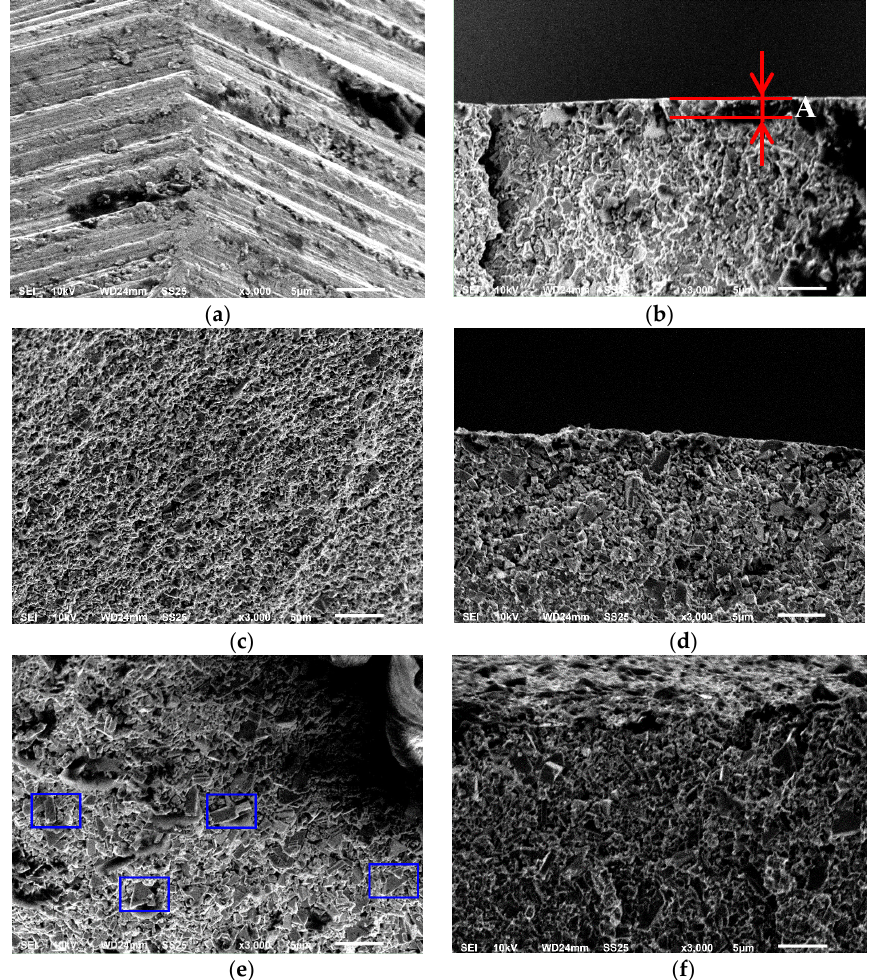
Figure 6. SEM images of the ( a ) surface and ( b ) cross-sectional surface of the original substrate, ( c ) surface and ( d ) cross-sectional surface of the substrate after chemical etching pretreatment, ( e ) surface and ( f ) cross-sectional surface of substrate after chemical etching and roughening. The red lines denote the thickness of the machined layer A made by the mechanical treatment. The blue rectangle points out the large-sized crystalline grains.